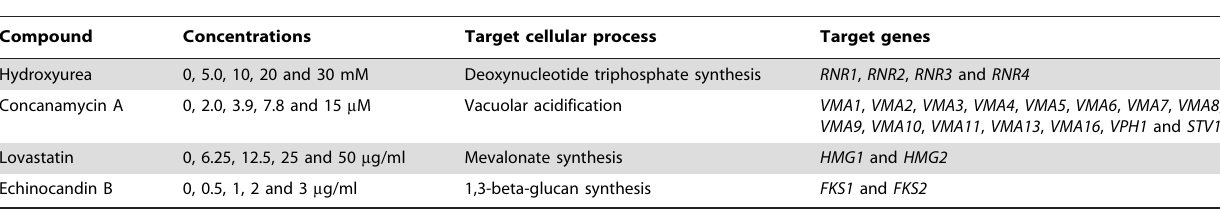
Table 1. Chemical compounds used in this